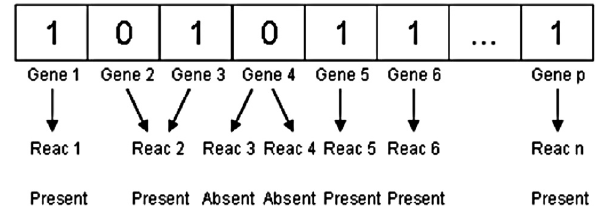
Figure 2: Bee representation of a metabolic